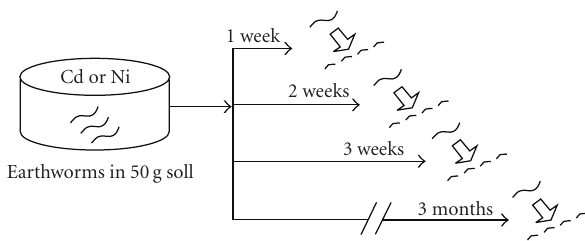
Figure 2: Experimental design. Metals (0, 0.5, or 10mg as Cd or Ni) were added to 50 g soil in a 600mL glass container. After 0-, 1-, 2-, 3-week, and 3 month exposures, E. fetida were cut into four rough segments (S1–S4). S1: head region, S2: anterior body region, S3: posterior body region, S4: tail